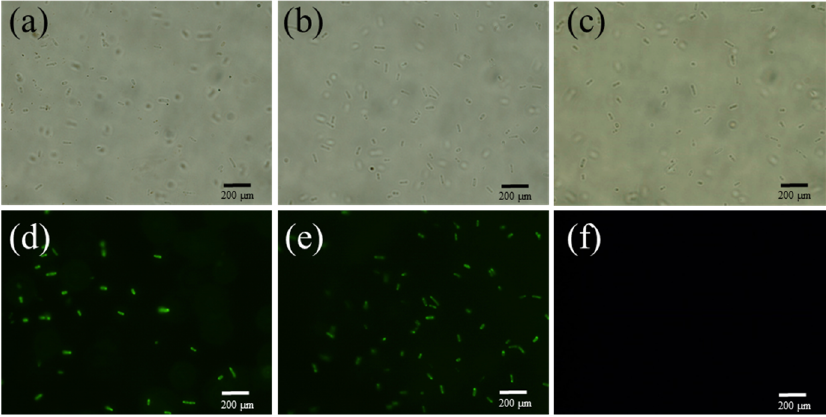
Figure 12. ( a – c ) Bright-field and ( d – f ) fluorescence images of E. coli incubated with ( a , b ) A-BG-AgNPs and ( b , e ) E-BG-AgNPs, and ( c , f ) show untreated bacteria after DCFH-DA treatment. Hemolytic evaluations were performed to determine the biocompatibility of BG extract stabilized AgNPs by incubating human red blood cells (RBCs) with different concentrations (31.25–500 µ g/mL) of BG-AgNPs. Figure 13 reveals that the viabilities of the RBCs were 90.6% in the presence of 500 µ g/mL of A-BG-AgNPs, which is 125- and 250-fold higher than the MIC to tested drug-resistant Gram-negative bacteria strains and P. aeruginosa .